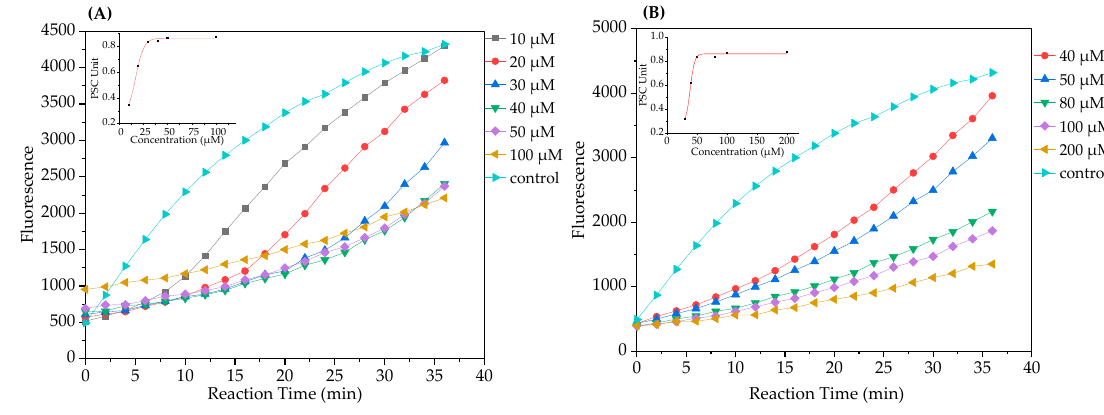
Figure 5. Time kinetics plots of TSC-2 ( A ) and TSC-3 ( B ) inhibition of non-fluorescent dichlorofluorescein (DCFH) oxidation by 2,2 ′ -azobis(2-amidinopropane) dihydrochloride (AAPH). (the inset is dose-response plots).